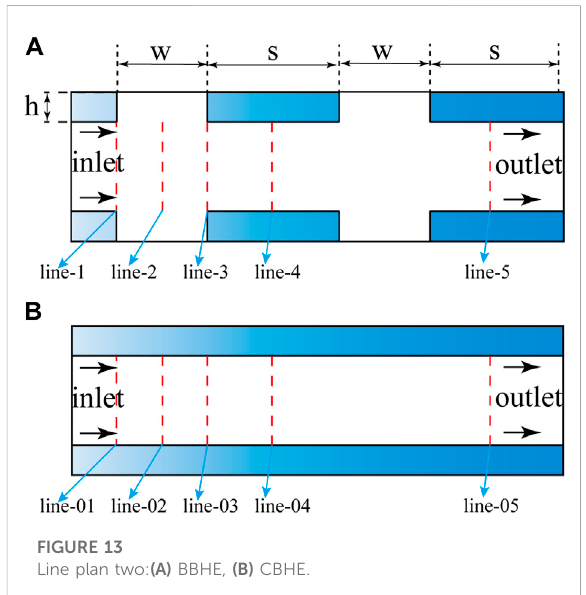
FIGURE 13 Line plan two: (A) BBHE, (B) CBHE.